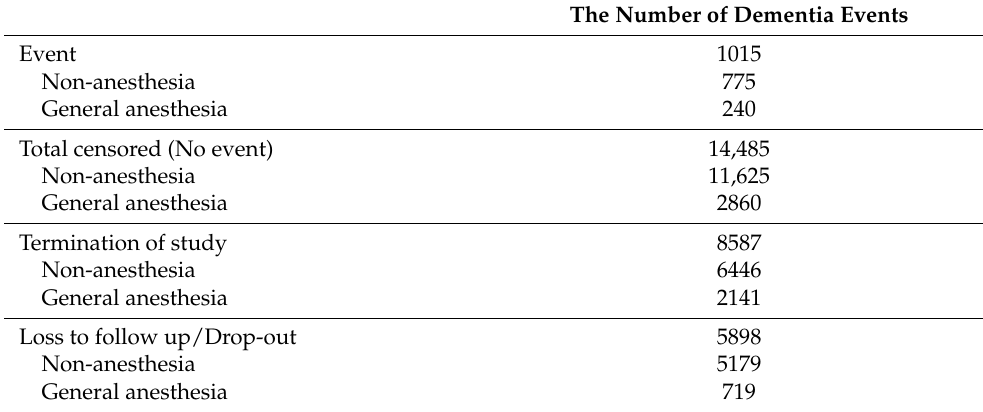
Table A1. Description of time to event and censored data.